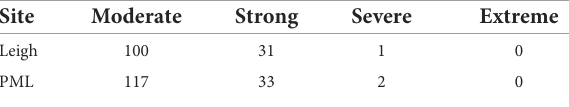
TABLE 2 Count of detected MHW events at Leigh and PML which are sorted by severity of event, where severity is defined by Hobday et al.